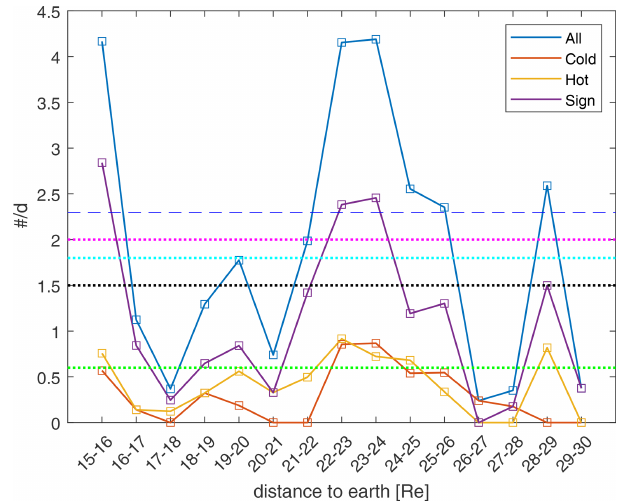
Figure 2. The occurrence rate of LMH structures as a function of the distance from Earth. The blue squares connected by blue lines show the occurrence rates for all structures. The red squares and line are for the cold LMHs, the yellow for the hot LMHs and the purple for sign change LMHs. The dashed blue line is the average occur- rence rate (2.3 per day), and the dotted coloured lines are the daily occurrence rates from literature: 1.5 (black; Turner et al., 1977), 2.0 (magenta; Sperveslage et al., 2000), 0.6 (green; Stevens and Kasper, 2007) and 1.8 (cyan; Xiao et al., 2014).